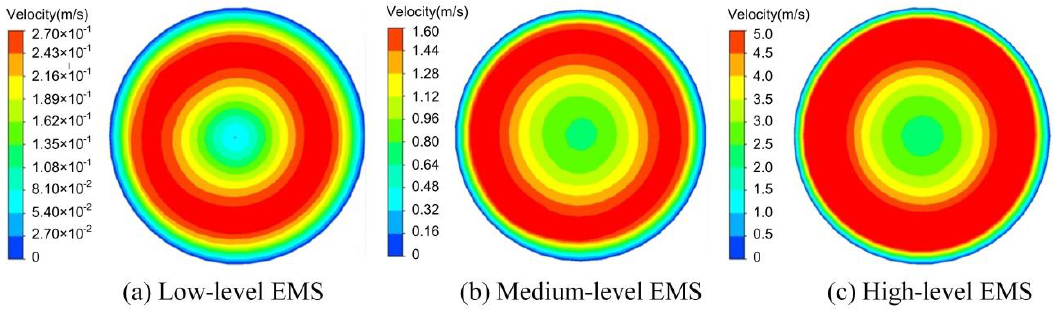
Figure 17. E ff ects of the operating conditions on the velocity and velocity distribution.